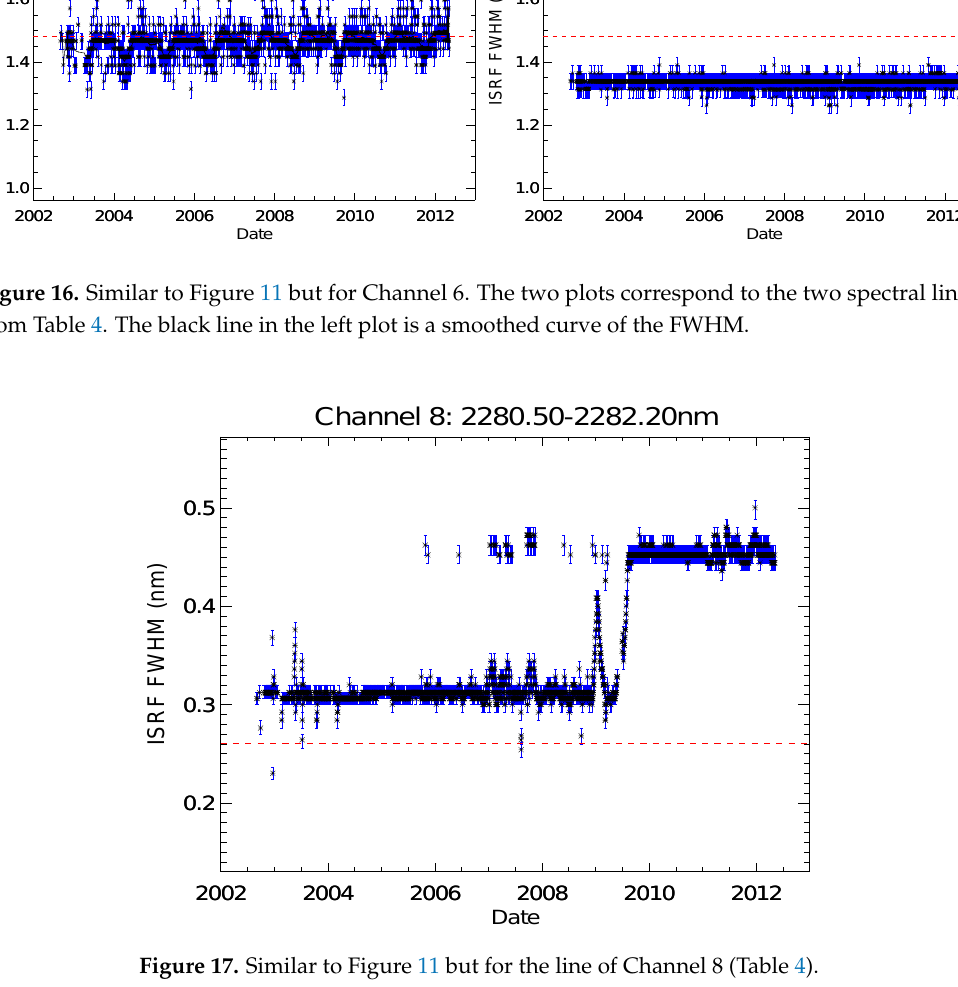
Figure 17. Similar to Figure 11 but for the line of Channel 8 (Table 4).